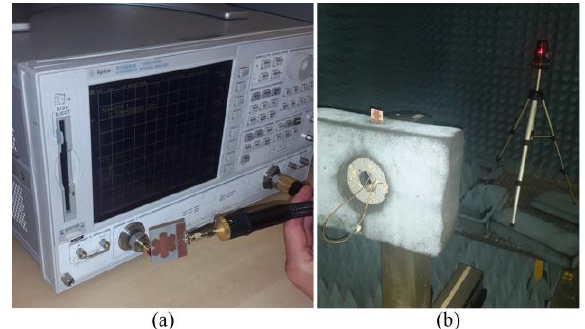
Figure 10: Measurement of (a) reflection coefficients by Network Analyzer, (b) radiation pattern inside an anechoic chamber.